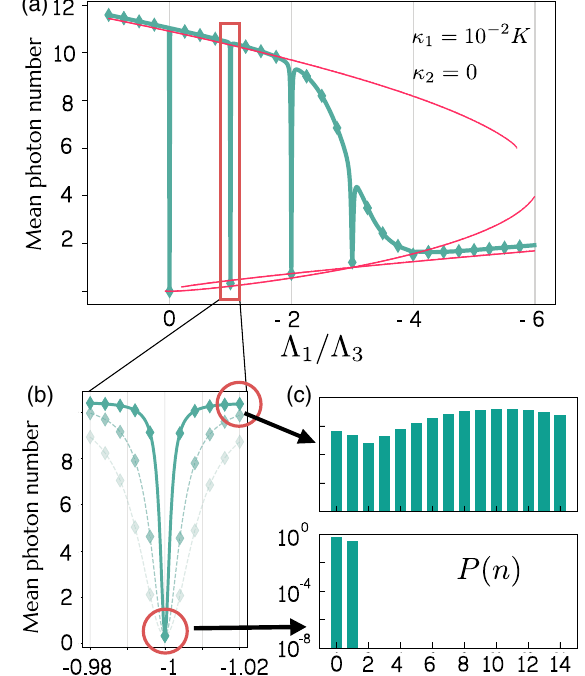
FIG. 5. Exact photon blockade using a nonlinear single-photon drive. (a) Mean steady-state cavity- a photon number as a function of the single-photon drive Λ 1 . The periodic, sharp drop in photon number corresponds to a generalized photon-blockade phenome- non, which occurs whenever the parameter r 1 [cf. Eq. (39)] is a non-negative integer. Solid lines: analytic exact solution. Dia- monds: master equation numerics. Photon numbers associated with the semiclassical stable amplitudes are also plotted (red lines). (b) Enlargements of one of the blockade antiresonances. Loss values are κ 1 ¼ K= 100 , K= 20 , and K= 10 , with more faded green corresponding to greater loss. (c) Steady-state photon statistics for two choices of Λ 1 corresponding to being either at (off) a blockaded parameter value. For all results, Δ ¼ K ,